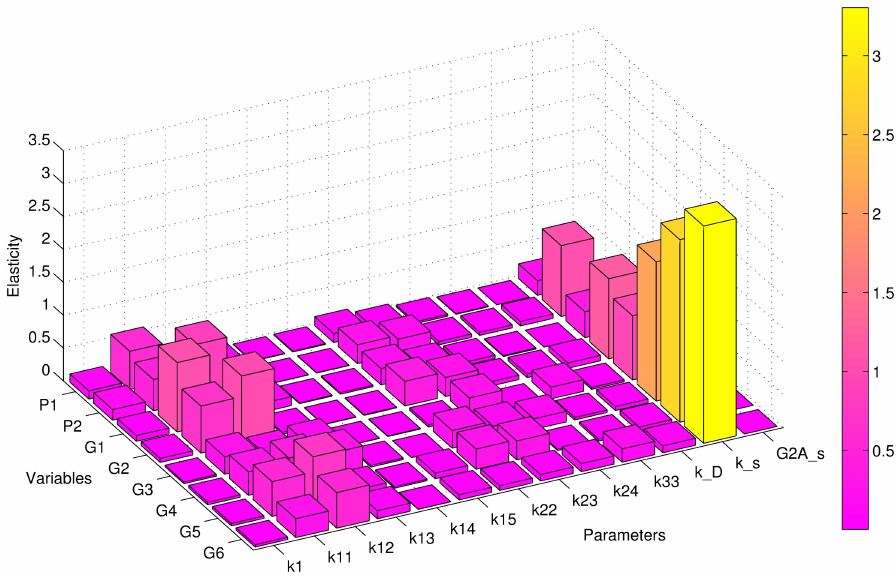
Fig 8. Elasticity analysis of parameters corresponding to eight types of polymers. Gi ( i = 1, 2, (cid:1)(cid:1)(cid:1) , 6) denotesa polymerwith i monomers at the plasma membrane. P 1 and P 2 indicate the monomer and dimer concentrations in the cytoplasm,